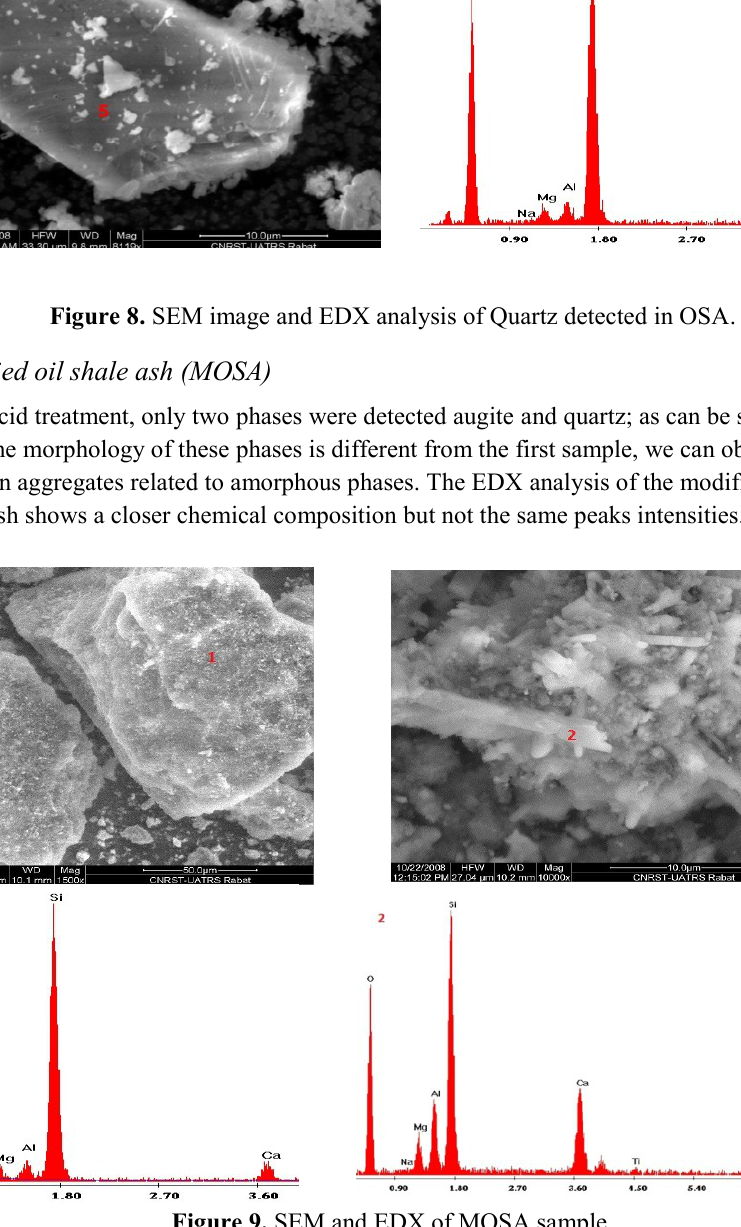
Figure 7. SEM and EDX images of OSA sample.